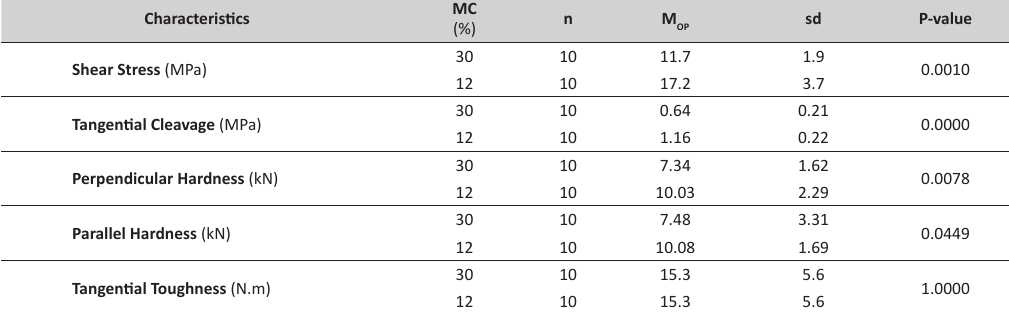
TAble 5. Other strength properties of Eucalyptus maidenii